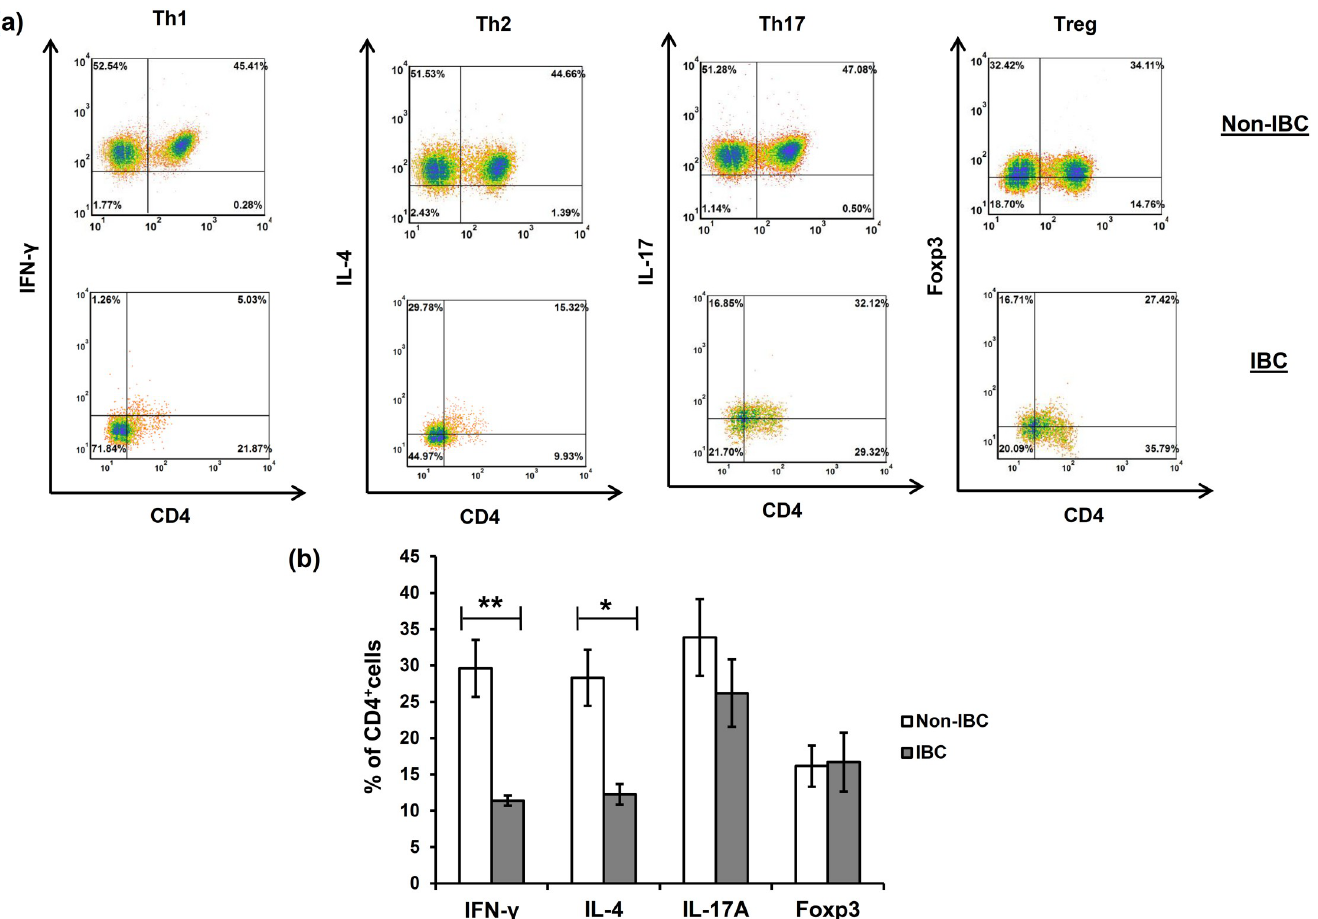
Fig 1. Basal frequencies of T helper subsets isolated from axillary tributaries of non-IBC and IBC patients. Higher proportions of Th 1 (IFN- γ + CD4 + ) and Th 2 (IL- 4 + CD4 + ) subsets are present in non-IBC than IBC patients. (a) Representative flow cytometry dot plots indicating the percentage of cells in each quadrant, and (b) Mean percentage ± SEM for non-IBC patients (n = 15), and IBC patients (n = 5). Data shown is representative for a single experiment. � P � 0.05, �� P � 0.01 as determined by Student’s t test.